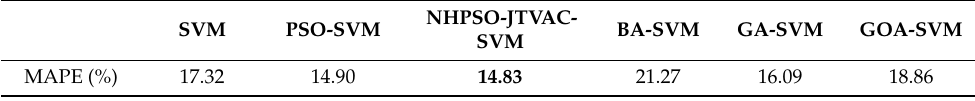
Table 8. Average MAPE of SVM, PSO-SVM, NHPSO-JTVAC-SVM, BA-SVM, GA-SVM, and